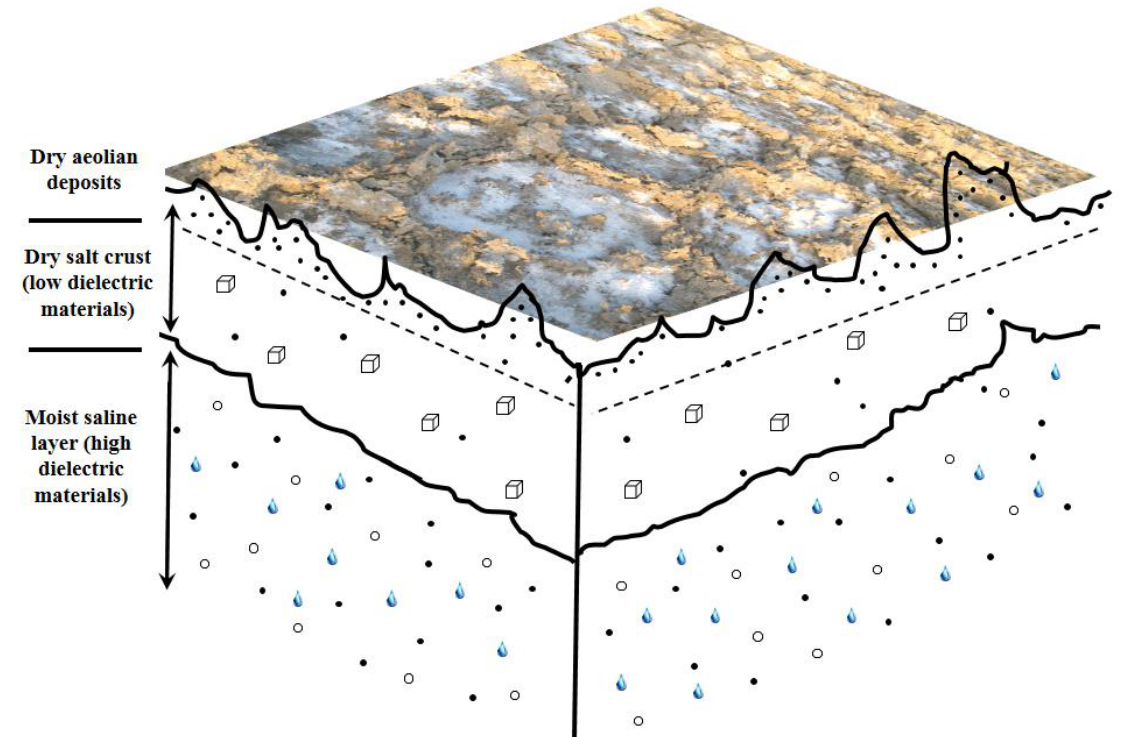
Figure 3. Subsurface scattering mechanism illustration. The subsurface structure of Lop Nur can be regarded as consisting of two layers with different dielectric properties, an upper dry layer and a moist saline subsurface layer. The GPR detected a boundary between the dry upper layer and the wet lower layer at a depth of approximately 50–55 cm ranging from the center to the edge of Lop Nur Lake